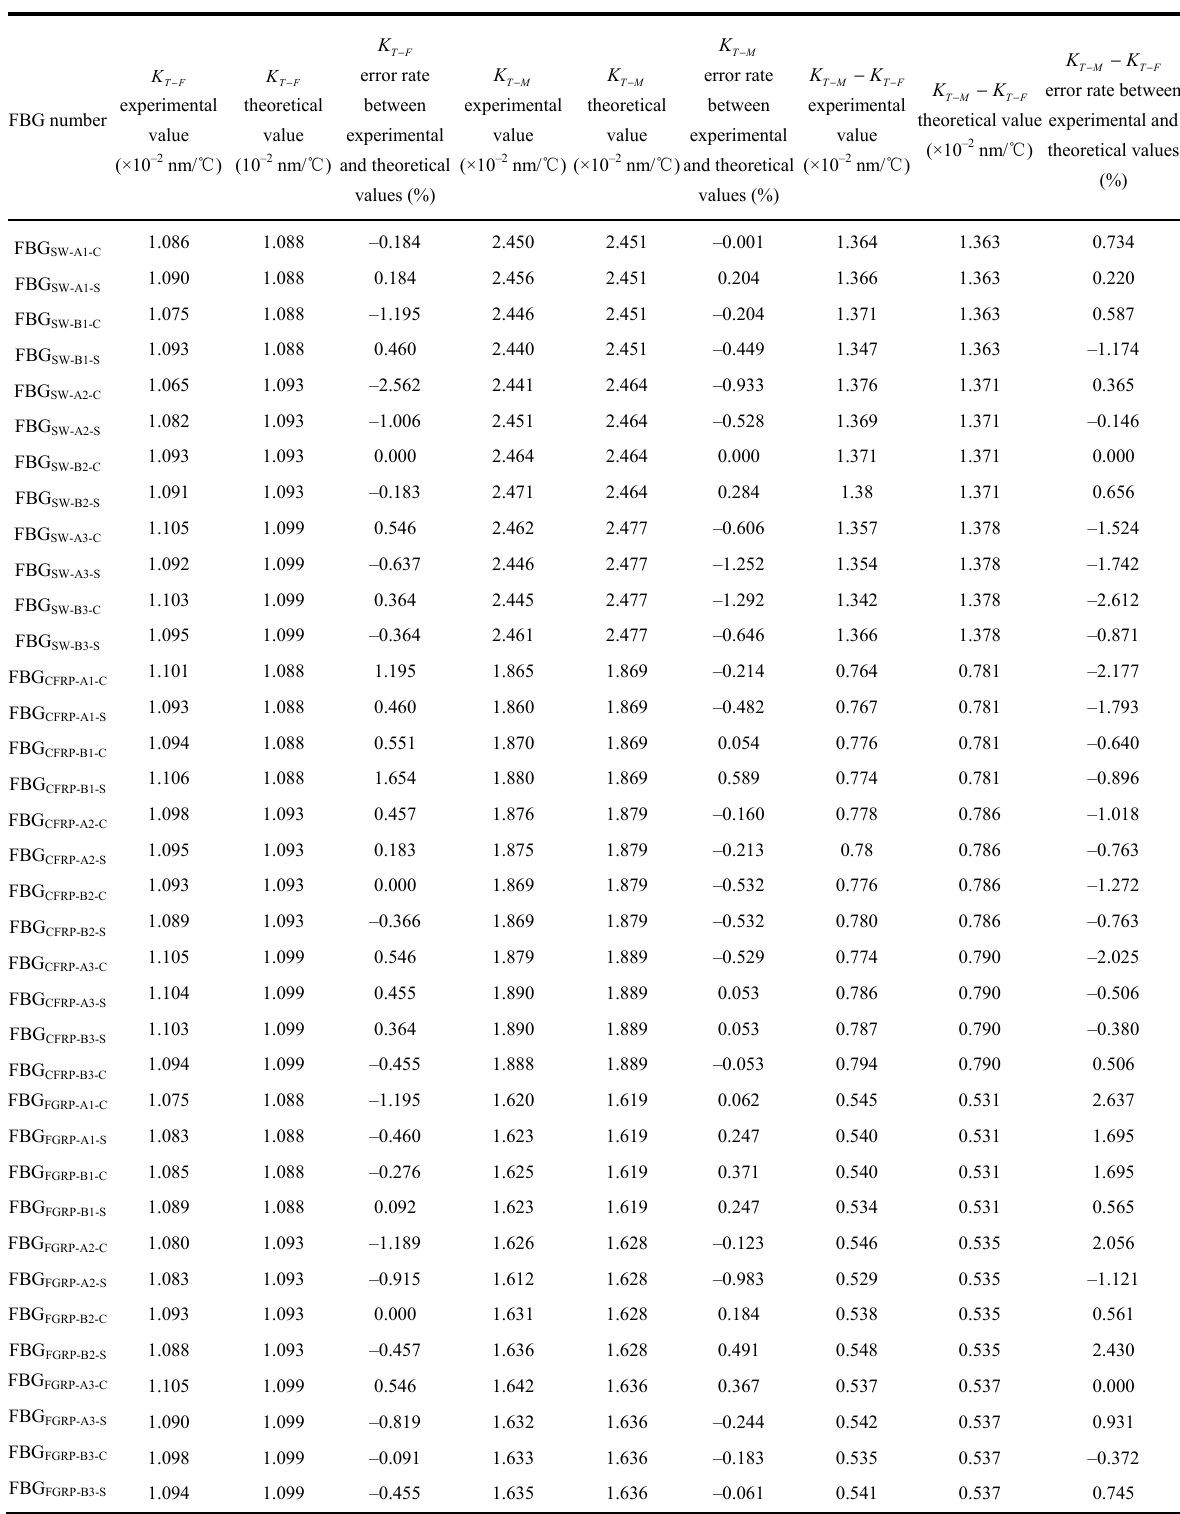
K − ） with the temperature sensitivity T M